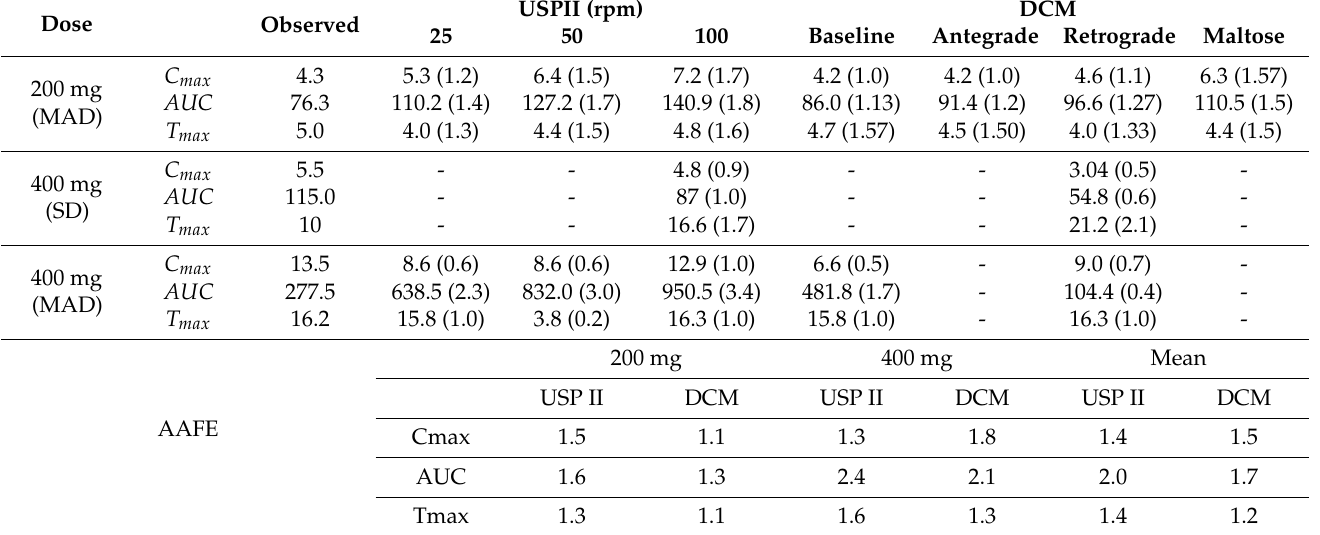
Table 1. Mean simulated and observed pharmacokinetic parameters (C Max (mg mL − 1 ), AUC 0–24 h (mg mL − 1 h − 1 ) and T max (h)) of theophylline following administration of Uniphyllin Continus